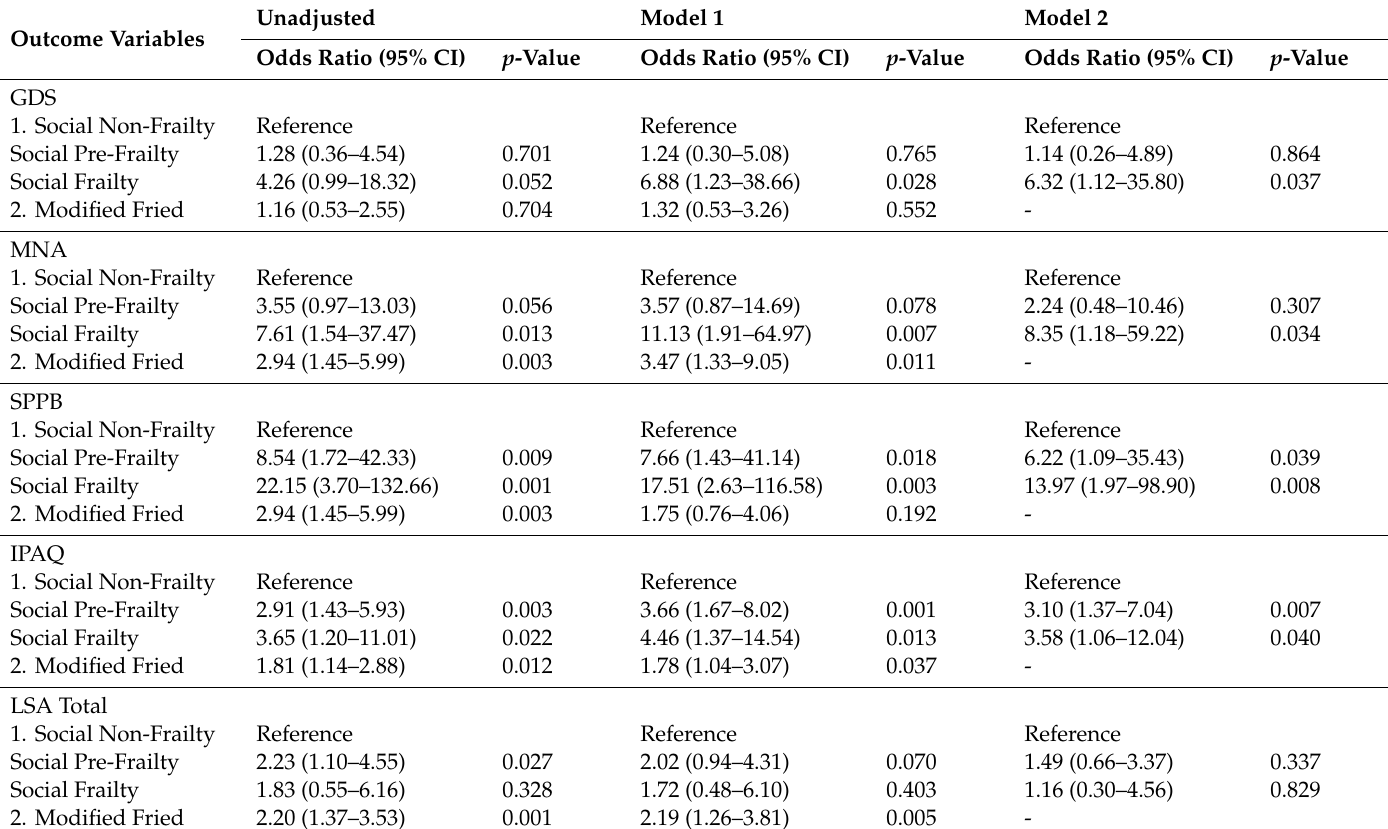
Table 5. Logistic regression models for social and physical